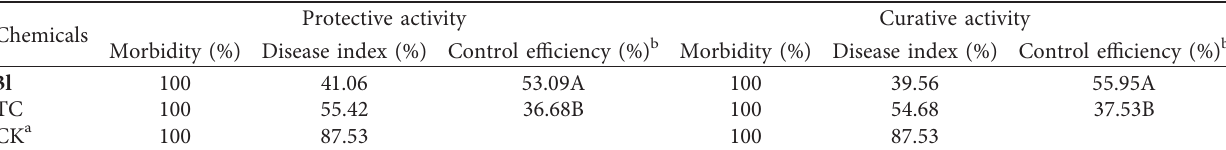
Table 2: In vivo bioactivity of compound 3l against rice bacterial blight at 200 μ g/mL (14 days after spraying).